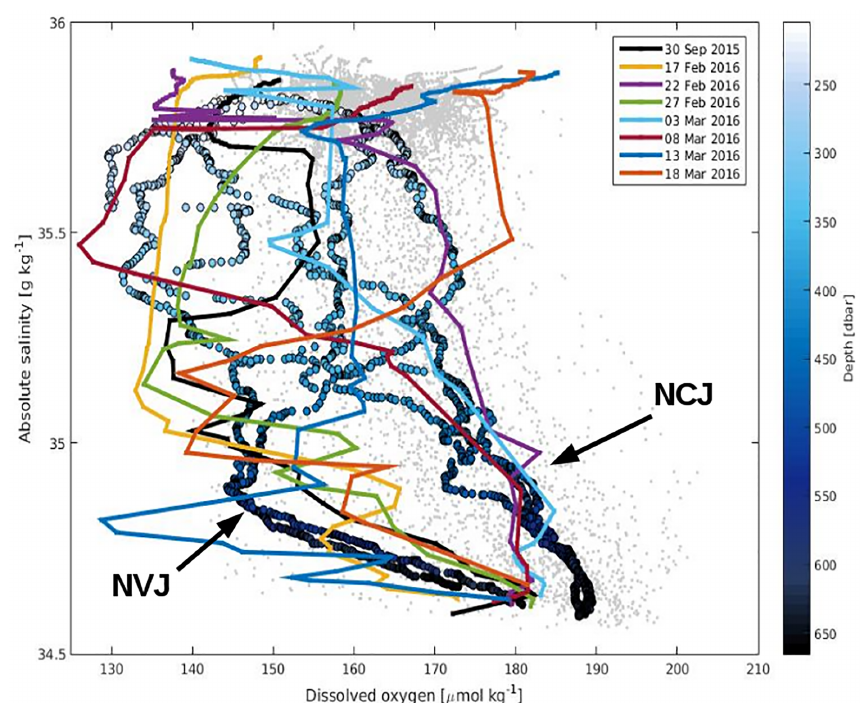
Figure B1. DOXY versus absolute salinity profiles of float 656 during O2 (colored lines) compared to characteristic NCJ and NVJ profiles made during the BIFURCATION cruise (scaled dots). The gray dots are the other measurements made by float 656. All the profiles are shown from the 1026kgm − 3 isopycnal to the 1030kgm − 3 one (i.e., between 200 and 650m depth